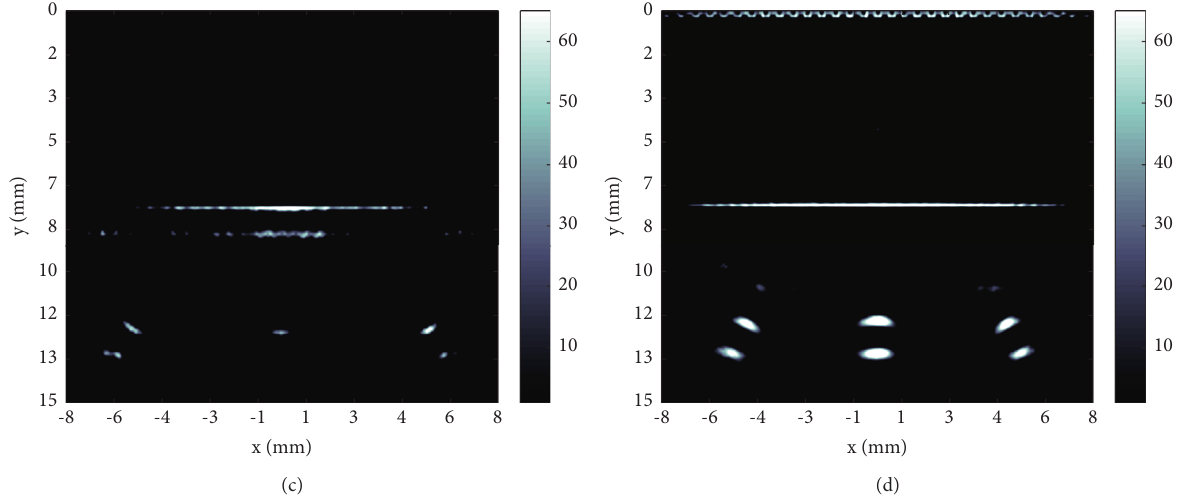
Figure 8: Focused imaging of model 2: (a) ML-TFM; (b) ML-SFM-1 (in equation (4), j � 7 : 23); (c) ML-SFM-2 (in equation (4), j � 1 : i ); (d) TML-TFM.